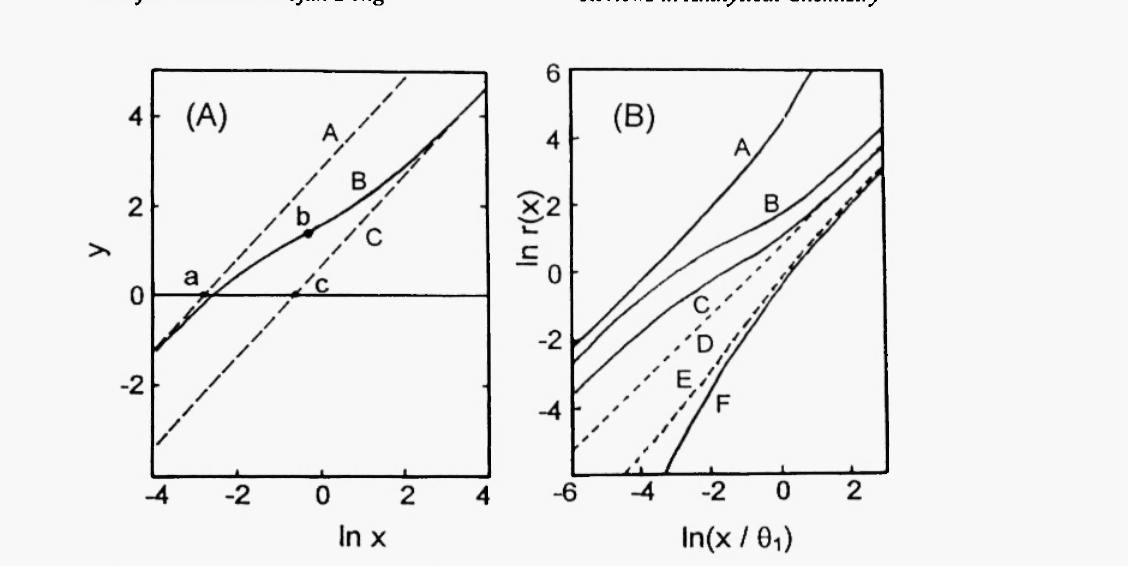
Fig. 24: (A) Nernst plot for various pairs of values of (θ,/θ 2 , δ): (40, 0) for A, (40, 0.3) for B, (20, 0.5) for C (4.05), for D, (2, 0.9) for Ε and (2, 1) for F. (B) Nernst plot showing the asymptotes, intercepts and inflection point. Curve Β is Eq. (41) with Ιηθι = 1, 1ηθ 2 = -3 and δ = 0.2. Asymptotes: A is Eq. (47) and c is Eq. (48). Intercept: a at (1η[θ 2 / )1-δ)], ο) and c at (Ιηθιδ, 0). Inflection point: b at (1ηθ,θ 2 (1-δ) / δ)" 2 ,1η((1-δ) / δ)). (From Ref.